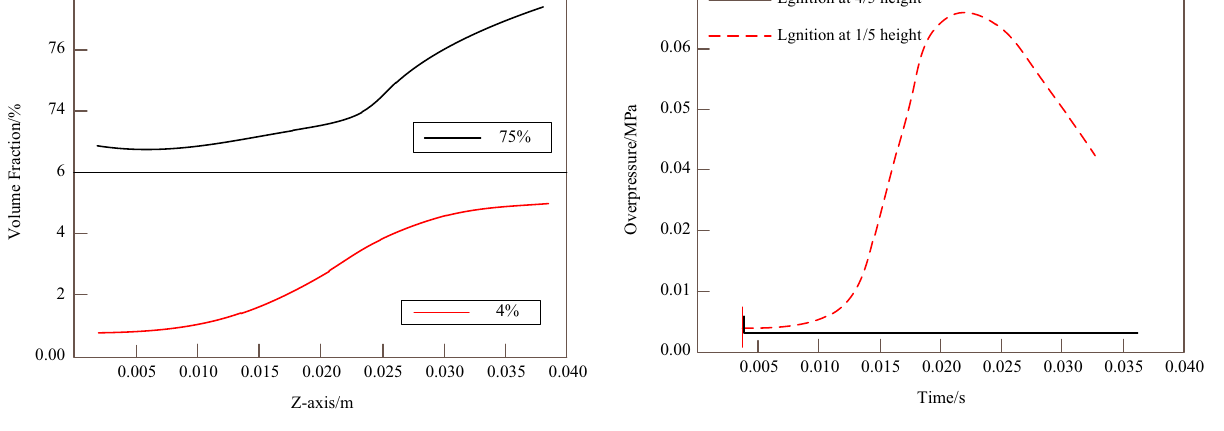
Figure 5: Overpressure – time curves ( 4% ) when the ignition point is located at the top and bottom of the tank, respectively.